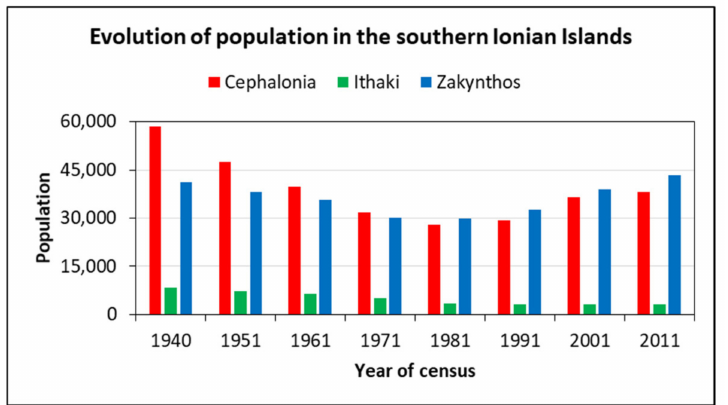
Figure 4. The population evolution in the southern Ionian Islands of Cephalonia, Ithaki and Zakyn- thos, which were heavily affected by the devastating 12 August 1953 mainshock and its foreshocks on 9 and 11 August, based on population census data of the Hellenic Statistical Authority from 1940 to 2011. The population of the three islands presented a decrease of 34.18% from 1951 to